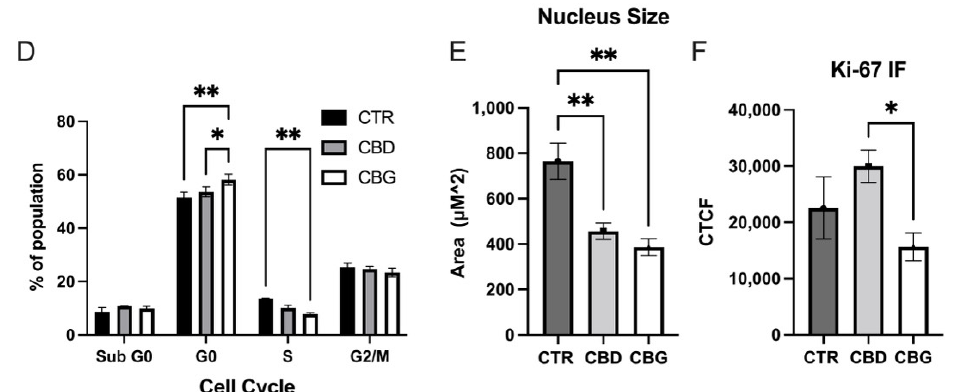
Figure 1. CBD and CBG treatment reduced proliferation in HuCC-T1 cells: ( A ). MTT assay results showing cell viability in HuCC-T1 48-h post treatment with control (0.1% DMSO), CBD or CBG; ( B ). time–course MTT assay at 100 µ M established dose over a 72-h time period; ( C ). propidium iodide histogram showing cell cycle doublet shown; population in each group (Sub G0, G0,S,G2/M) shown; ( D ). percentage of each cell cycle population in each treatment was quantified, n = 3; ( E , F ). quantification of Alex Fluor 488 staining of Ki-67 (green) and DAPI staining of nuclei size; ( E ). and fluorescence intensity; ( F ). in all three groups with a significant decrease in the size of the nucleus; ( F ). CTCF: corrected total cell fluorescence. * p < 0.05 vs. 0.1% DMSO or CTR; ** p < 0.01 vs. 0.1% DMSO or CTR; *** p < 0.001 vs. 0.1% DMSO or CTR .